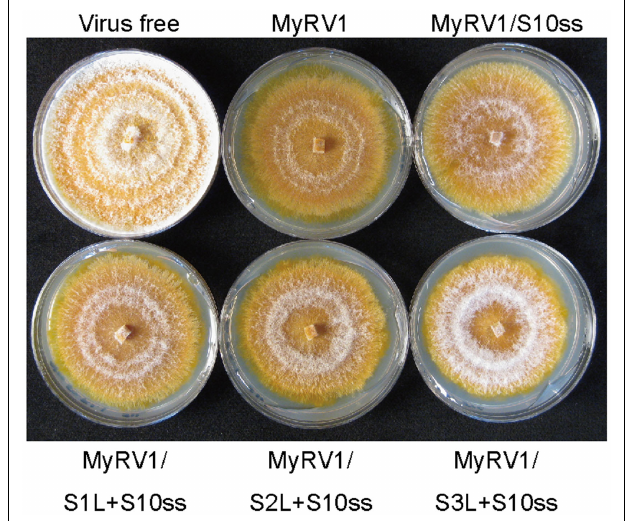
FIGURE 3 | Effects of rearrangements on virus symptom induction. Fungal colonies were grown on PDA for 8 days under the bench top conditions approximately 24˚C. C. parasitica strain EP155 was infected with wild-type MyRV1 (MyRV1), MyRV1/S10ss2 (MyRV1/S10ss), MyRV1/S1L + S10ss2 (MyRV1/S1L + S10ss), MyRV1/S2L + S10ss2 (MyRV1/S2L + S10ss), or MyRV1/S3L + S10ss2 (MyRV1/S3L + S10ss).Virus-free EP155 was cultured in